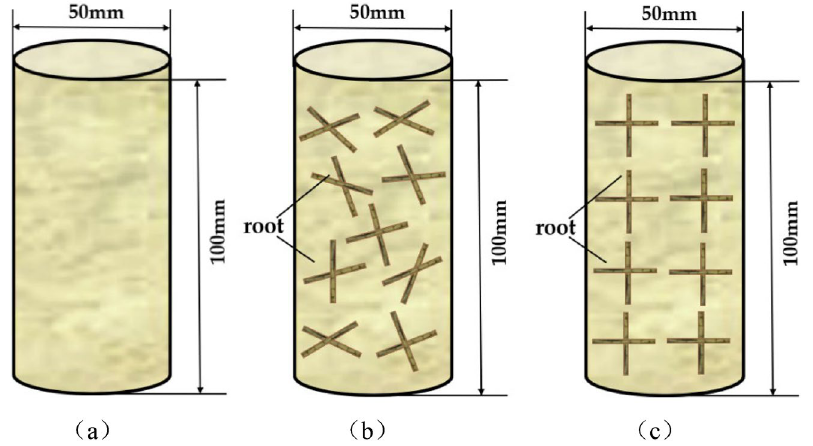
Figure 2. Three root distribution patterns. ( a ) Plain soil, ( b ) mixed reinforced soil, and ( c ) crossed reinforced